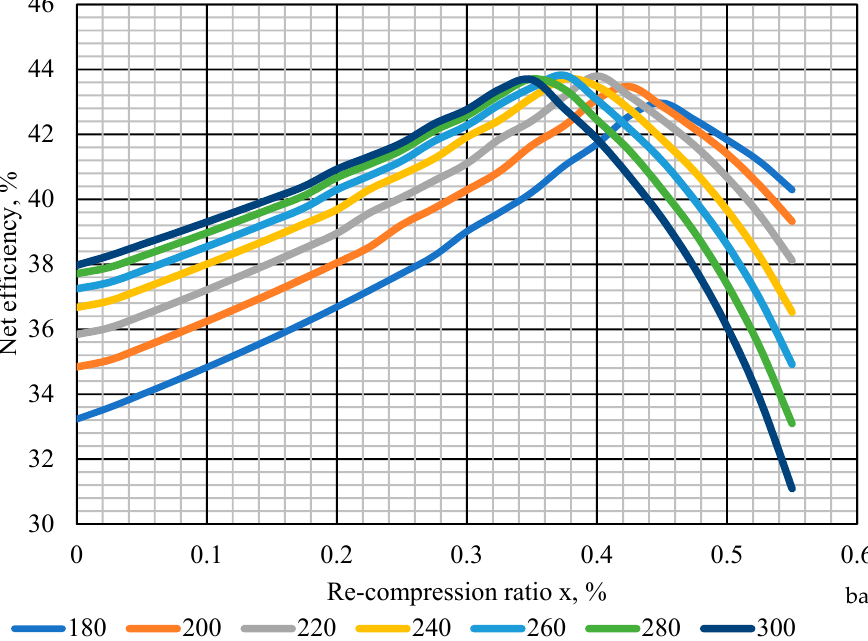
Figure 6. The effect of inlet pressure and recompression ratio on the net efficiency.